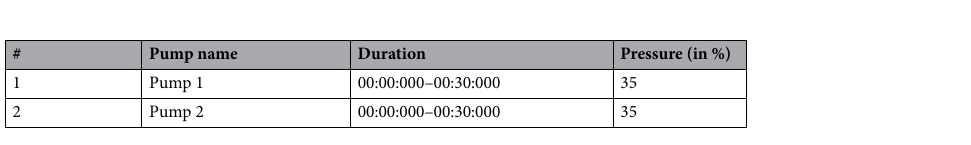
Table 3. Program sequence for demonstrating conventional pressure-driven mixing experiment handled by the system (experiment